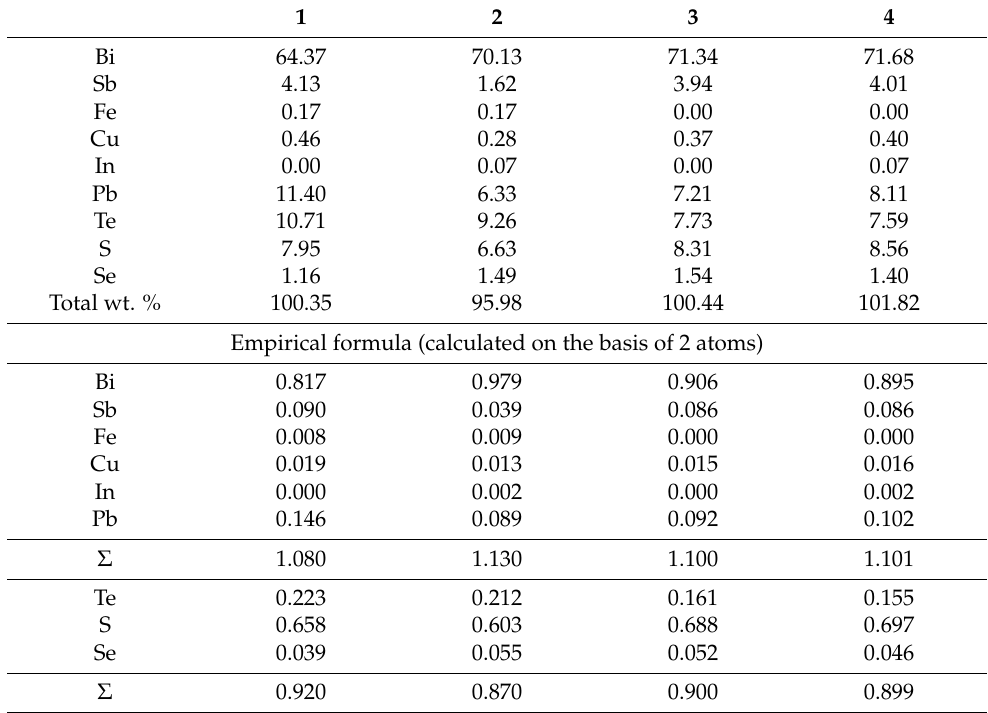
Table 8. Representative WDS microanalyses of unnamed (BiPb)(TeS) mineral phase from ˇCuˇcma (Majersk á valley).